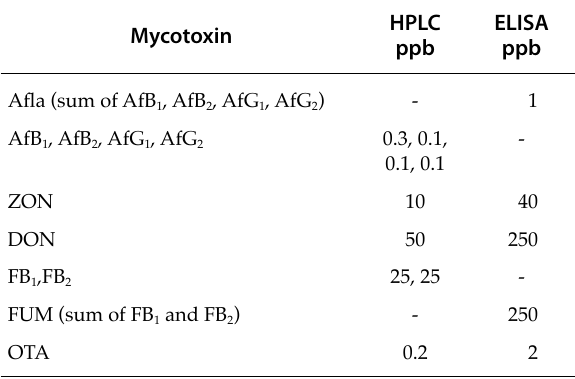
Table 1. Limits of detections (LOD) of methods applied. Mycotoxin